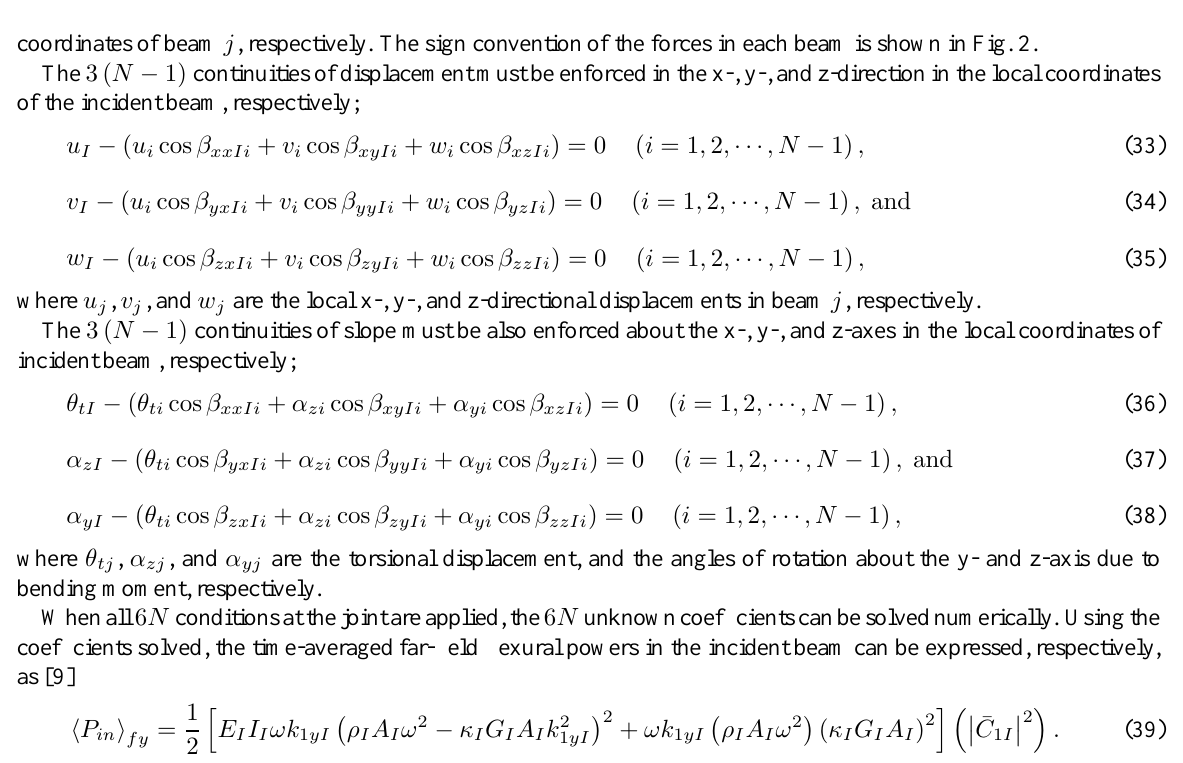
Fig. 6, continued. The power transmission and reflection coefficients of two semi-infinite Timoshenko beams with the same material and geometrical properties joined at 90 ◦ : (a) Case of the incident BDFW with wavenumber k 1 , (b) Case of the incident SDFW with wavenumber k 2 , (c) Case of the incident longitudinal